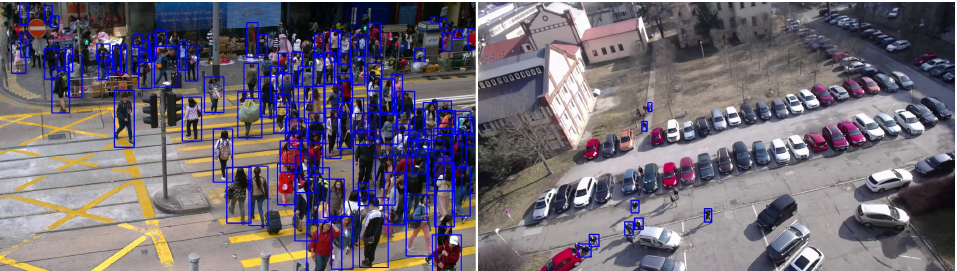
Figure 7. Sample of pedestrian detection from a low distance ( left ) and high distance ( right ).